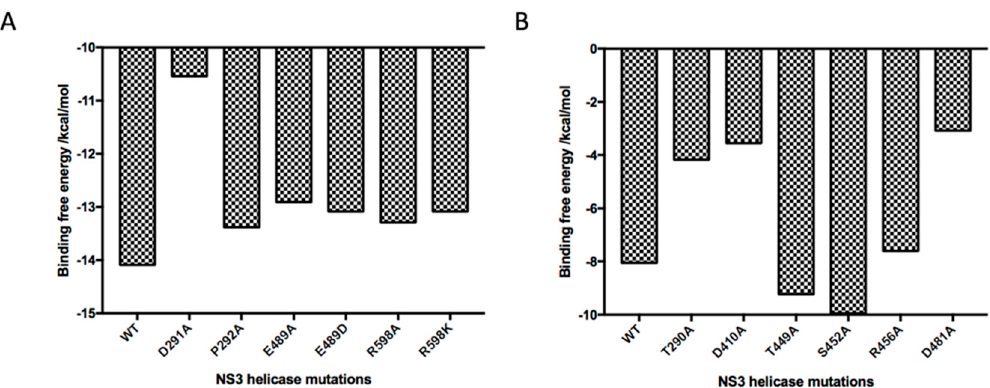
Figure 7. Absolute binding free energy values for two ligand–protein docking complexes using PDLD / S-LRA / β methodology. All energies are presented in Kcal / mol. ( A ) Calculated free energy of Compound 1 to NS3 helicase Wildtype (WT) and mutants (D291A, P292A, E489A, E489D, R598A, and R598K). ( B ) Calculated free energy of Compound 2 to NS3 helicase Wildtype (WT) and mutants (T290A, D410A, T449A, S452A, R456A, and D481A).